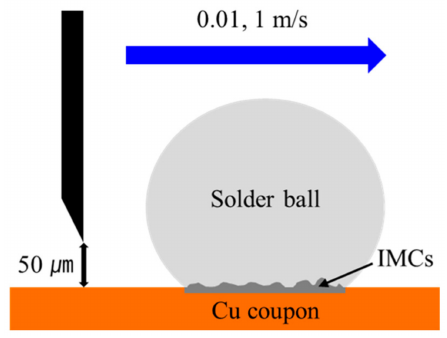
Figure 2. Schematic of the ball shear